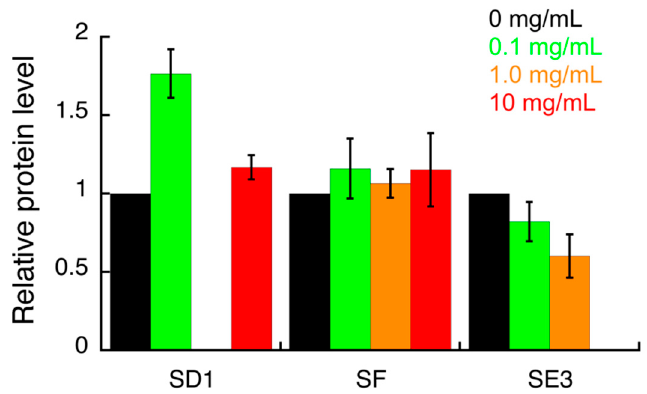
Figure 3. Densitometric analysis of the Western blot images (shown in the Supplementary Materials) indicating the effects of S. campanulata on H. pylori G27 BabA adhesin expression. H. pylori cells were treated with different concentrations of S. campanulata sub-fractions for 4 h and protein level of BabA adhesin was determined by Western blot, using a specific anti-BabA antibody. Values are expressed as means ± SD of two independent experiments. Sub-fraction SD1 (20% Cyhex/EtOAc), sub-fraction SE3 (70% MeOH/H 2 O), and sub-fraction SF (80% Cyhex/EtOAc) were from fractions D, E, and F, respectively.